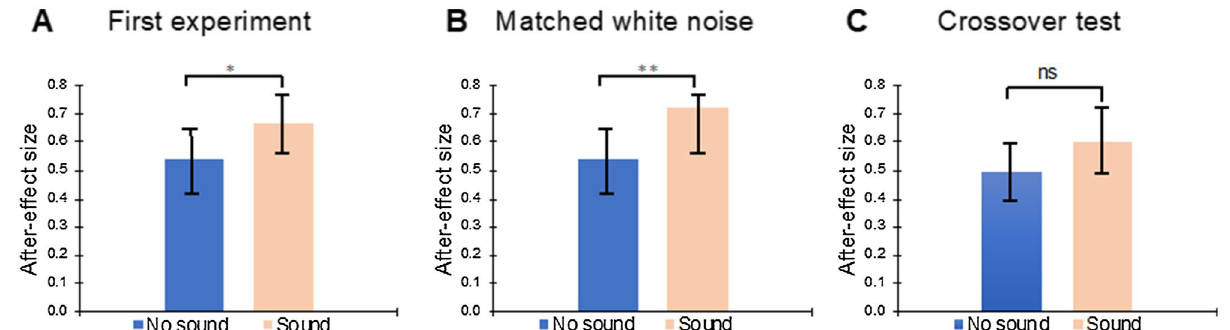
Figure 5. Difference in after-effect size between the treatment with sound (“sound”) and the treatment without sound (“no sound”), for each experiment. Y-axis: Mean after-effect size across participants (for the definition of after-effect size, see Fig. 3). *: difference is significant at p < 0.05; **: difference is significant at p < 0.01; ns difference is not significant at p < 0.05; see Table 1 for the